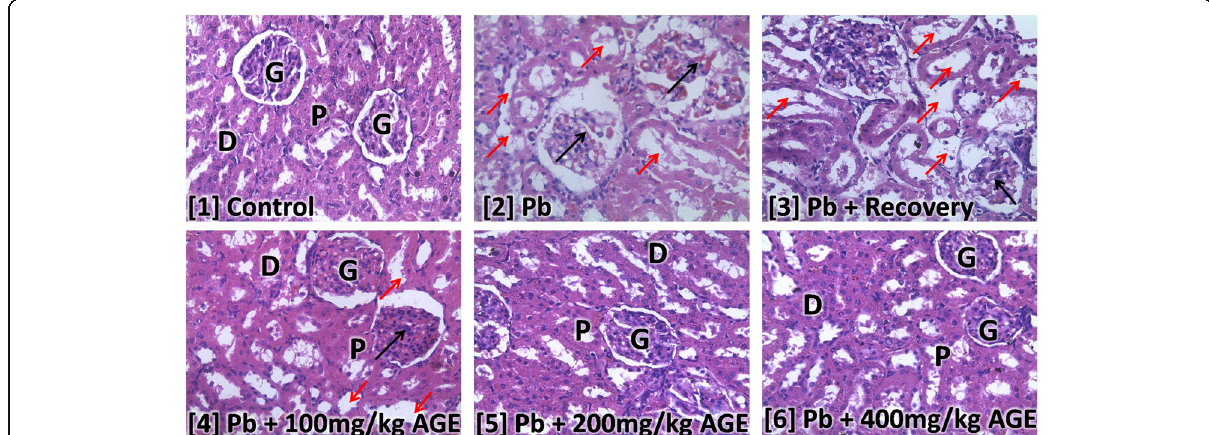
Fig. 4 Histological effects of AGE on the kidney of Wistar rats with Pb-induced kidney injury. Magnification = × 400; [1] to [6] = groups 1 to 6; AGE = aqueous garlic extract; Pb = Lead; G = glomerulus; P = proximal tubule; D = distal tubule; Black arrow = atrophied glomerulus; Red arrow = tubular and interstitial